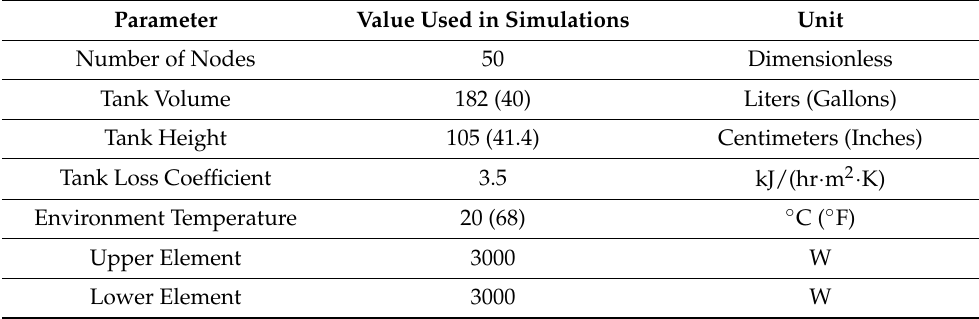
Table 3. Parameters used to characterize TYPE 534 hot water tank in this study. Parameter Value Used in Simulations Unit Number of Nodes 50 Dimensionless Tank Volume 182 (40) Liters (Gallons) Tank Height 105